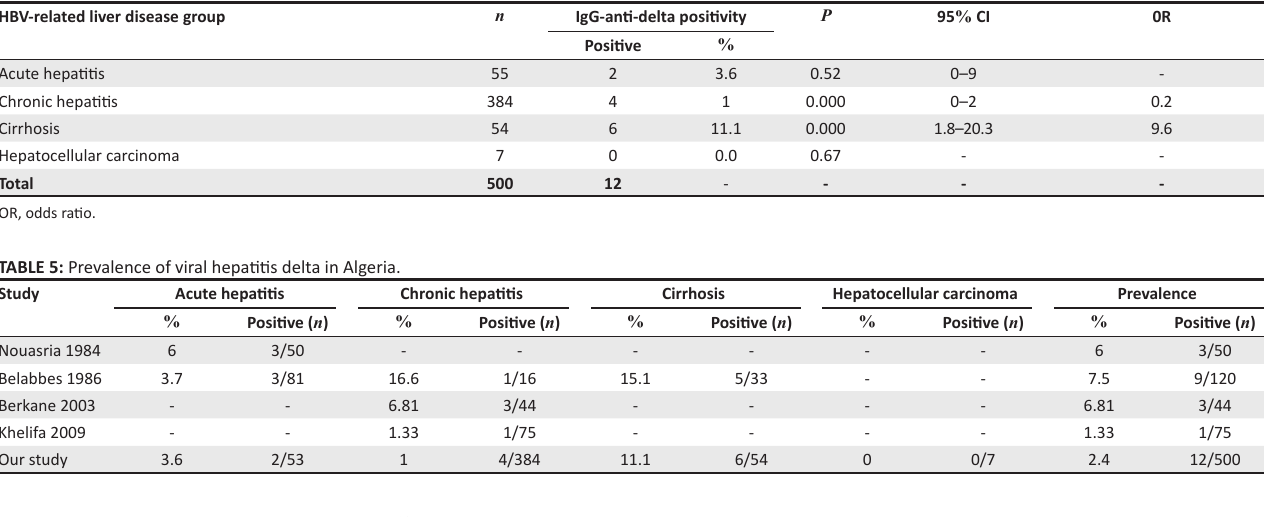
TABLE 4: Prevalence of hepatitis delta virus infection among hepatitis B virus (HBV) infected subjects with liver disease.